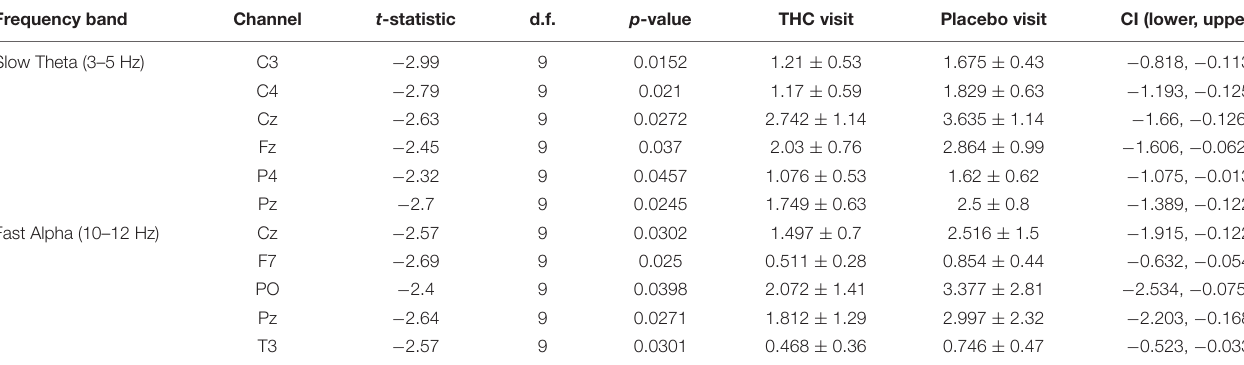
FIGURE 3 | Resting state eyes open by visit. During THC visit, spectral power fell relative to placebo visit at slow Theta and fast Alpha frequency bands. Topographic maps show widespread decreases in midline Theta (top row) and fast Alpha (bottom row) from THC visit to placebo visit. Filled black circles mark channels that were significantly different between the visits prior to FDR correction for multiple comparisons. TABLE 2 | Paired t -test statistics for absolute spectral power during RSEO comparing the THC and placebo